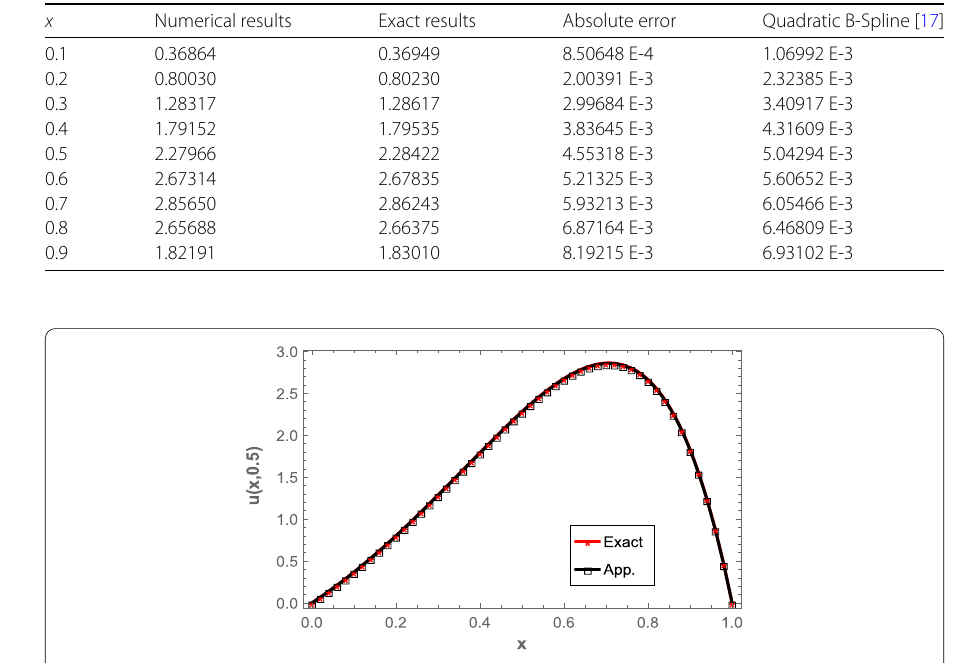
Table 1 The computational results to the first problem at y = 0.5, x , y ∈ [0,1]